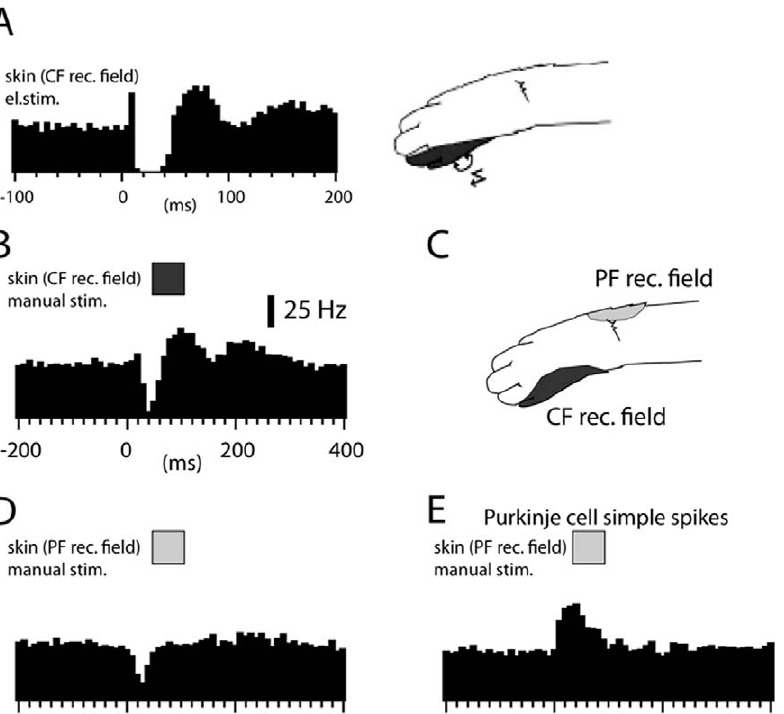
Figure 8. DCN cell responses to skin stimulation. (A) Spike responses of a DCN cell to electrical skin stimulation (single shock, 0.2 ms) within the climbing fiber receptive field. (B) Responses evoked by manual skin stimulation (50 ms) in the climbing fiber receptive field. (C) Locations of the parallel fiber and climbing fiber receptive fields for the PC input to the DCN neuron. (D) Response evoked by manual skin stimulation in the PC- parallel fiber receptive field. (E) For comparison, a peristimulus histogram of PC simple spike responses to manual skin stimulation within the parallel fiber receptive field. Histogram bin widths, 5 ms in (A), otherwise 10 ms.